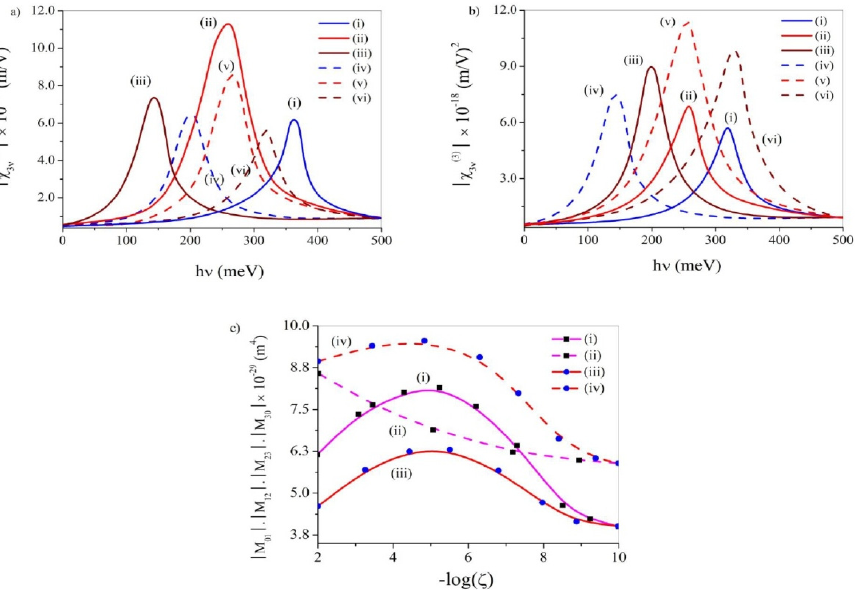
Figure 10. THG vs. h υ diagrams with ( a ) OPA and ( b ) EPA. In these diagrams (i) ADWN and ζ = 10 − 10 , (ii) ADWN and ζ = 10 − 6 , (iii) ADWN and ζ = 10 − 2 , (iv) MLWN and ζ = 10 − 10 , (v) MLWN and ζ = 10 − 6 , (vi) MLWN and ζ = 10 − 2 . ( c ) Depiction of GF for THG vs. − log( ζ ): (i) with ADWN and OPA, (ii) with ADWN and EPA, (iii) with MLWN and OPA and (iv) with MLWN and